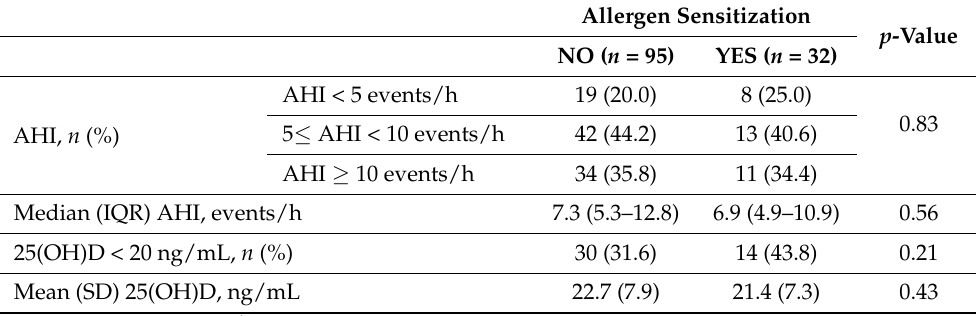
Figure 4. The scatterplot shows the existence of a significant negative correlation between platelet count (PLT) and serum 25(OH)D levels in the cohort of OSAS patients (rho = −0.25, p = 0.005). Blue points represent individual values for each participant while the black line corresponds to the linear regression. Table 4. Correlations between serum 25(OH)D levels and Body Mass Index percentile, platelet count, Mean Platelet Volume, Apnea – Hypopnea Index, SpO 2 nadir in OSAS patients. Table 5. Apnea–Hypopnea Index and serum 25(OH)D levels in OSAS patients with and without allergen